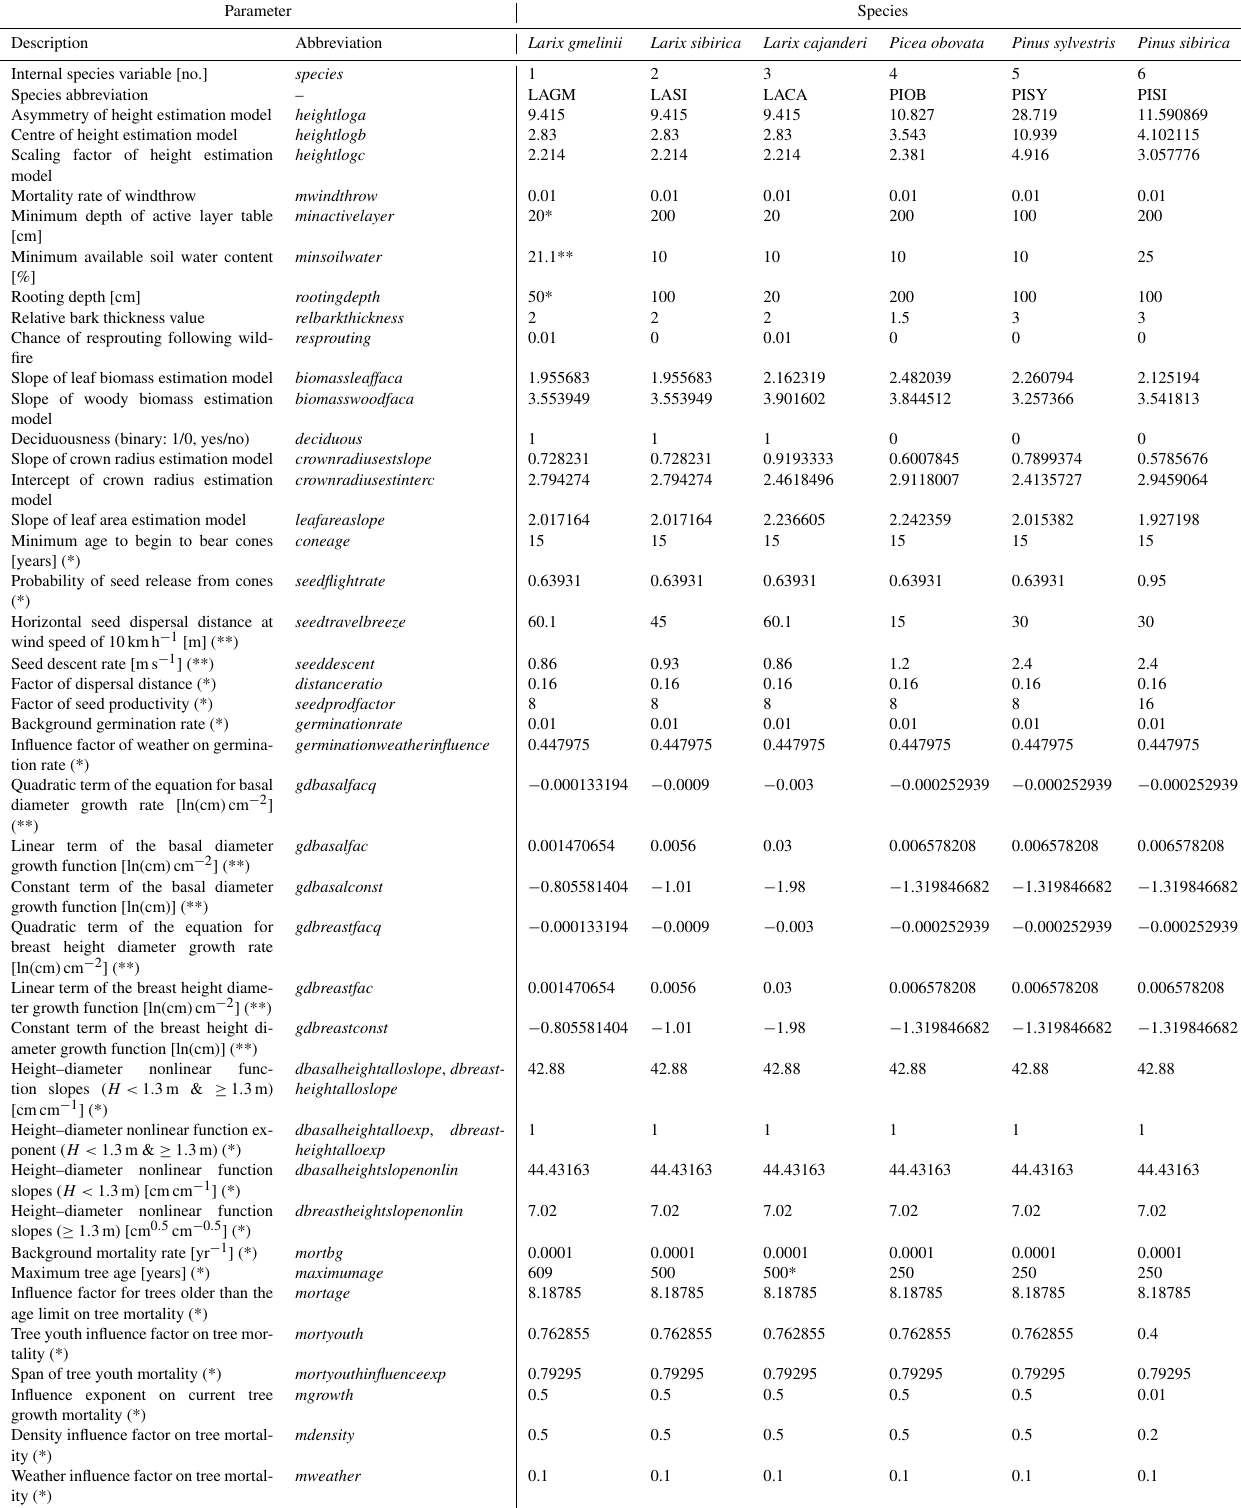
Table 2. Species traits and model variable values in LAVESI either newly introduced for this study, adjusted from the initial version LAVESI v1.01 (*), or introduced in the predecessor LAVESI-WIND v1.0 (**). Values from * Abaimov et al. (1998), ** Sato et al. (2016), own analyses, educated guess, or parameter